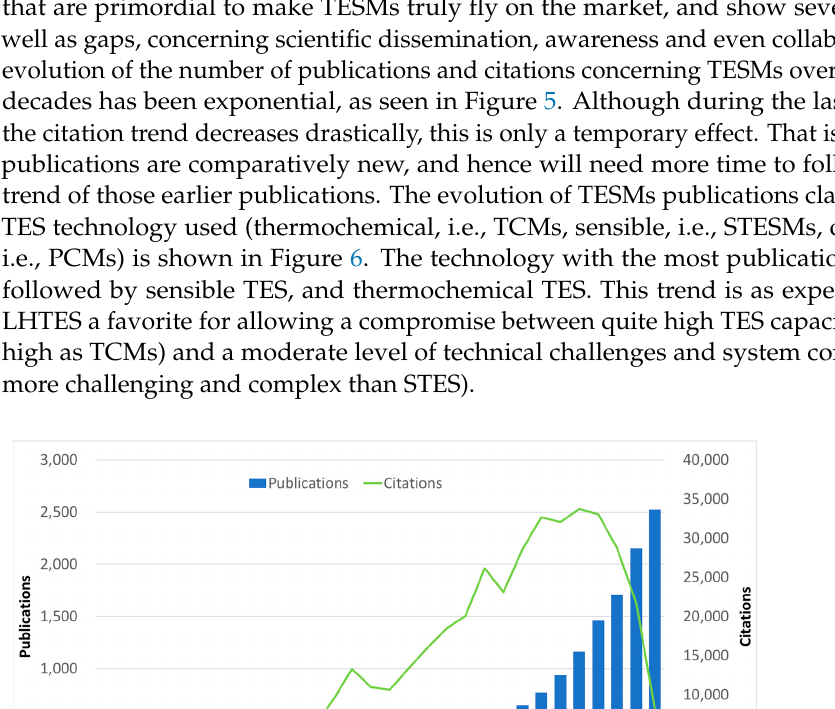
Figure 6. Publications evolution classified per thermal energy storage technology types, over the last two decades.